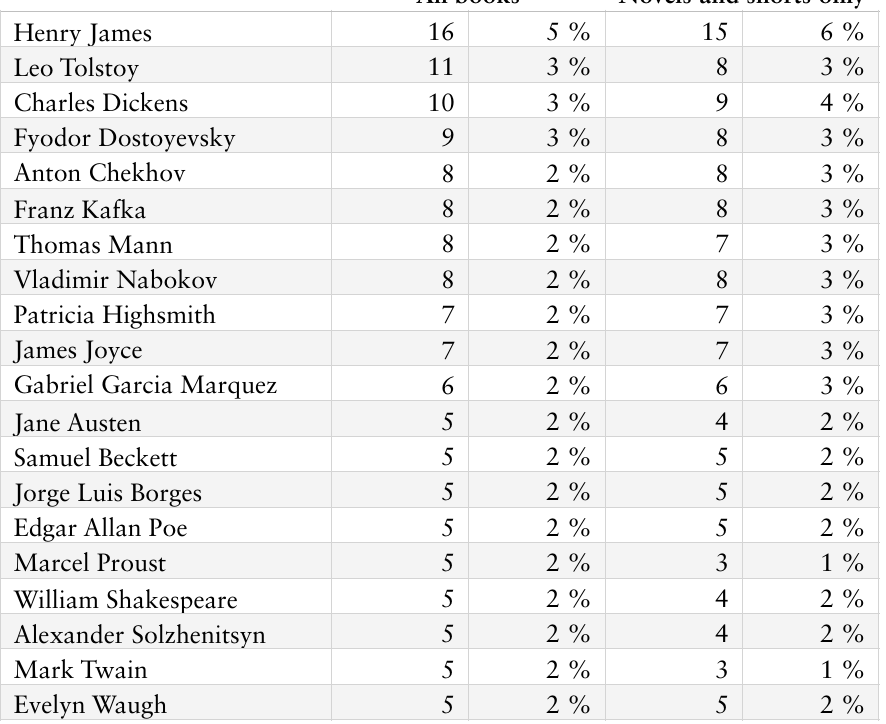
Table 1: Most mentioned authors in descriptions of separate books Note: The table lists the number of “mentions” and the percentages of descriptions in which they are mentioned. Source: author’s own